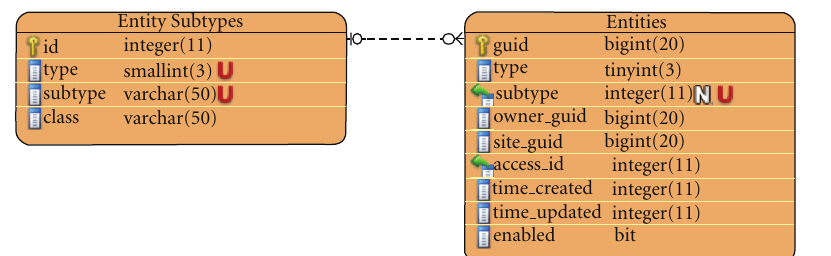
Figure 10: The “Entity Subtypes” table.